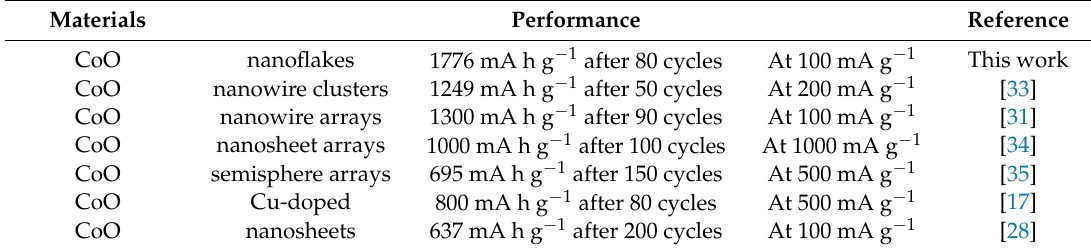
Table 1. Results reported in the literature on the electrochemical performance of CoO